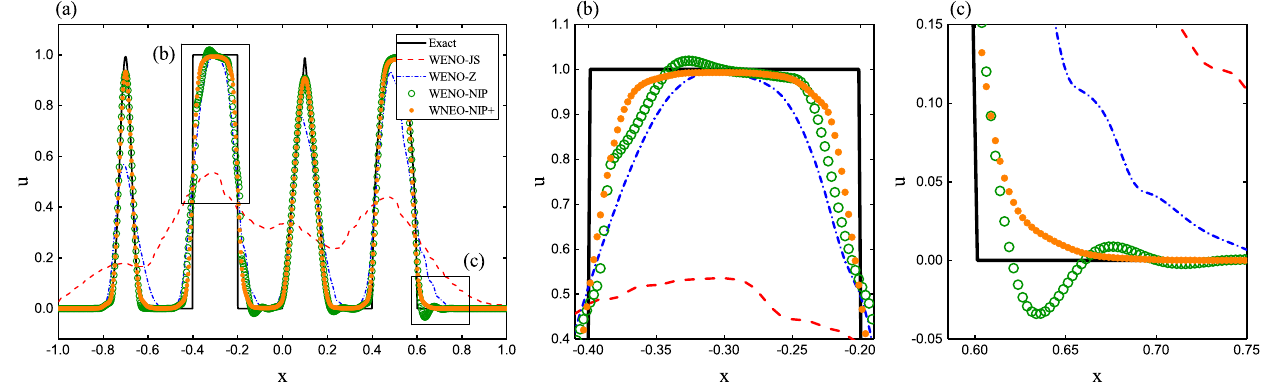
Figure 3. ( a ) Results of the Gaussian-square-triangle-ellipse linear test with t = 2000 (1000 cycles) and N = 800. ( b ) Zoomed-in view of the top of the square wave. ( c ) Zoomed-in view of right bottom of the ellipse